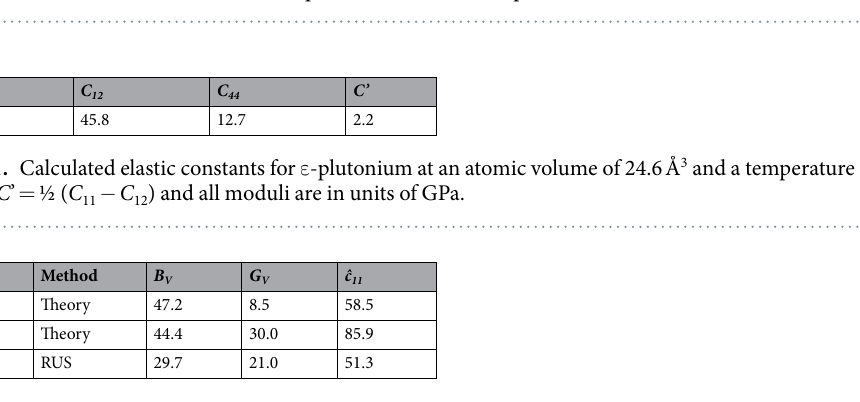
Table 2. Calculated Voigt averages of bulk and shear moduli B V = ( C 11 + 2C 12 ) /3 and G V = ( C 11 − C 12 + 3C 44 ) /5 and ĉ 11 = B V + 4 G V /3 for ε -Pu together with corresponding theoretical and resonant ultra-sound spectroscopy 25 data for δ -Pu. All moduli are in the units of